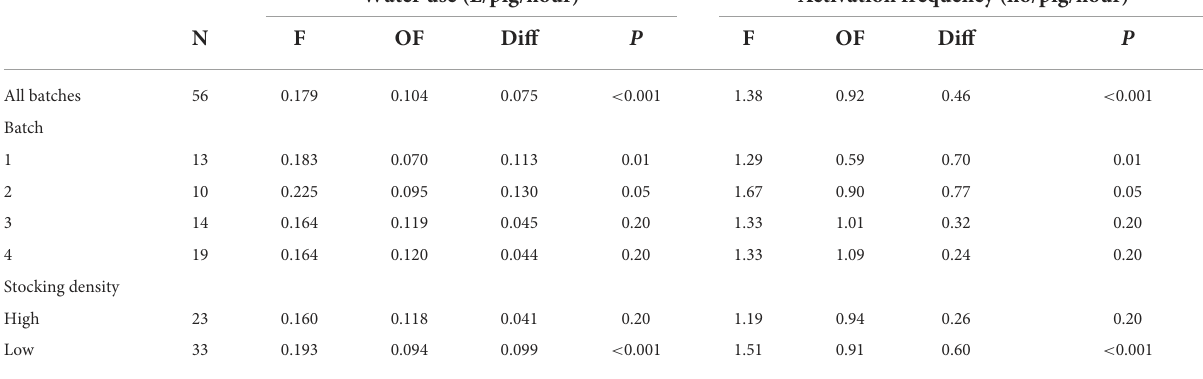
TABLE 3 The mean water use and activation frequency for the sensor located at the same side of the pen as the feeder (F) and for the sensor located on the opposite side of the pen as the feeder (OF), across all batches, for each batch and for each stocking density treatment (High: 0.73 m 2 /pig, 18 pigs; Low: 1.21 m 2 /pig, 11